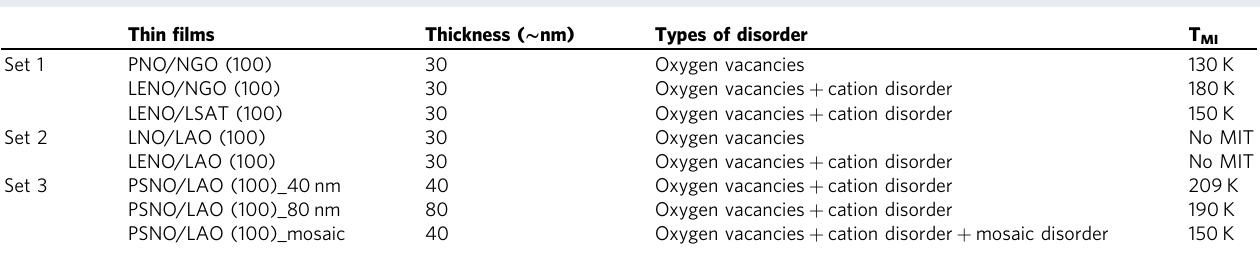
Table 1]. A comparison of resistivities ( ρ ) as a function of Table 1 Description of RNiO 3 fi lms used in DC transport and THz-TDS